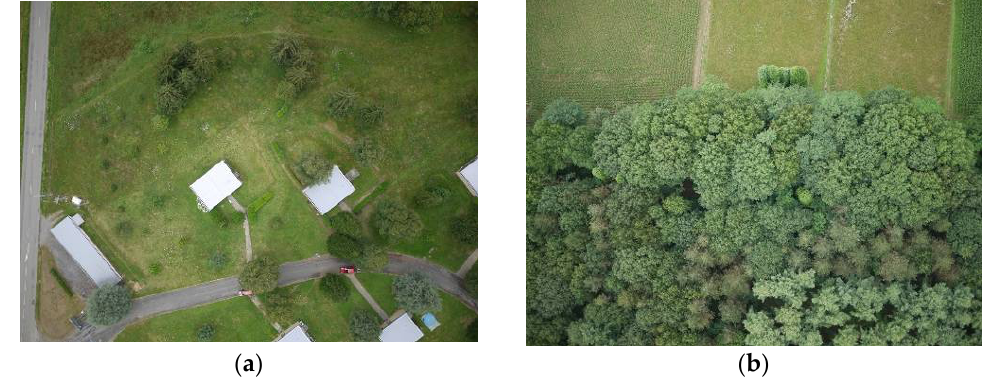
Figure 9. The two different reference images in Dataset 4. ( a ) The reference image for the results in Figure 8; ( b ) The reference image for the results in Figure 10.